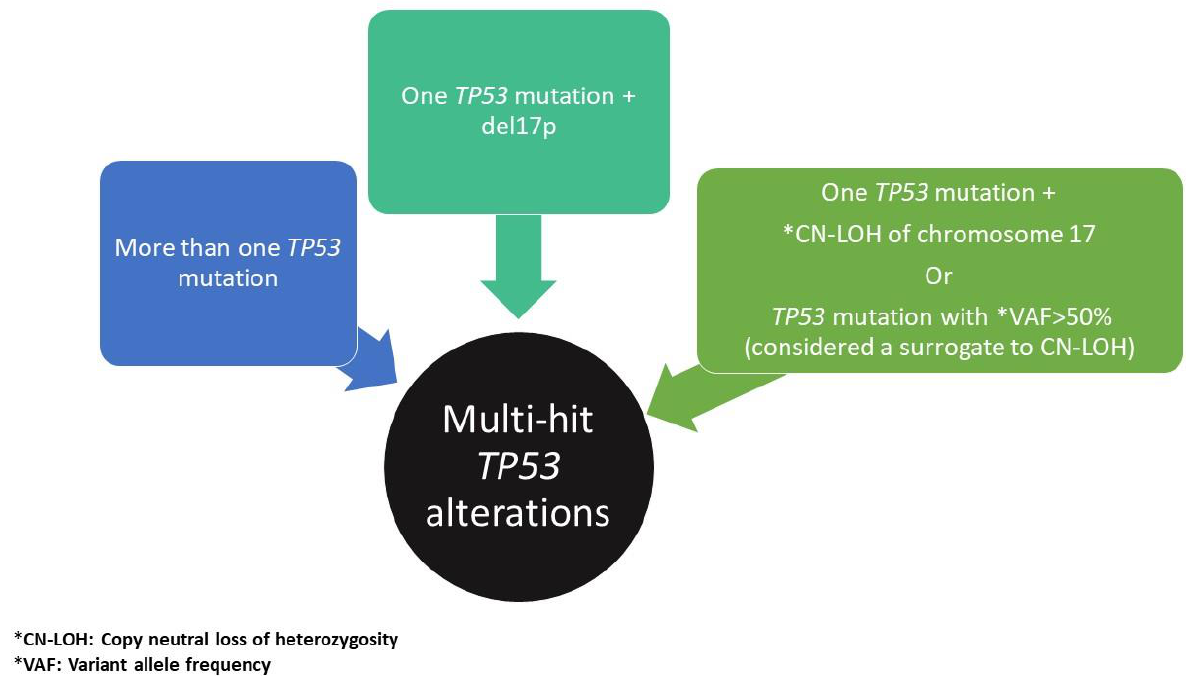
Figure 1. Multi-hit TP53 defining alterations.